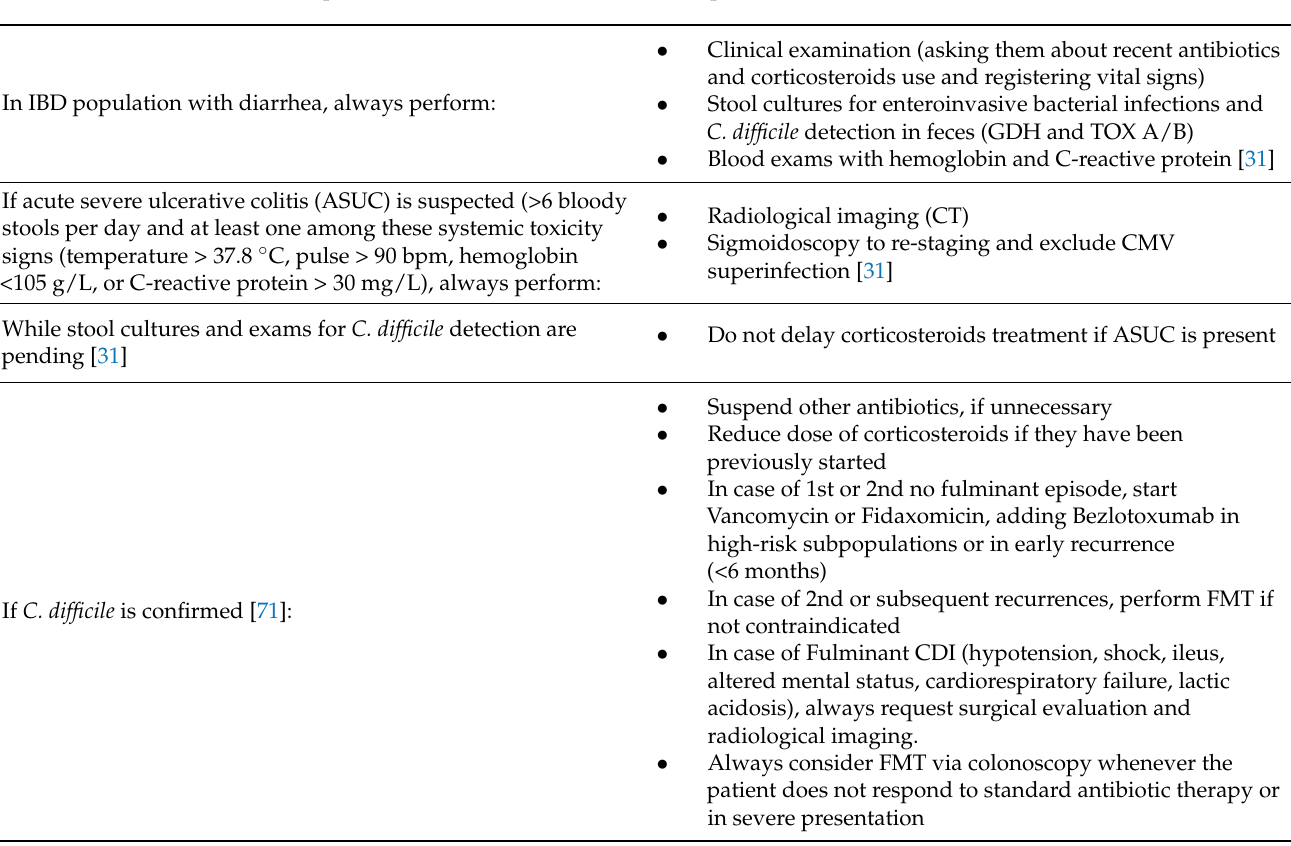
Table 2. Keypoints on management of Clostridioides difficile infection (CDI) in adults with IBD. CDI—Clostridioides Difficile infection; TOX A/B—ELISA for detecting C. difficile toxin in